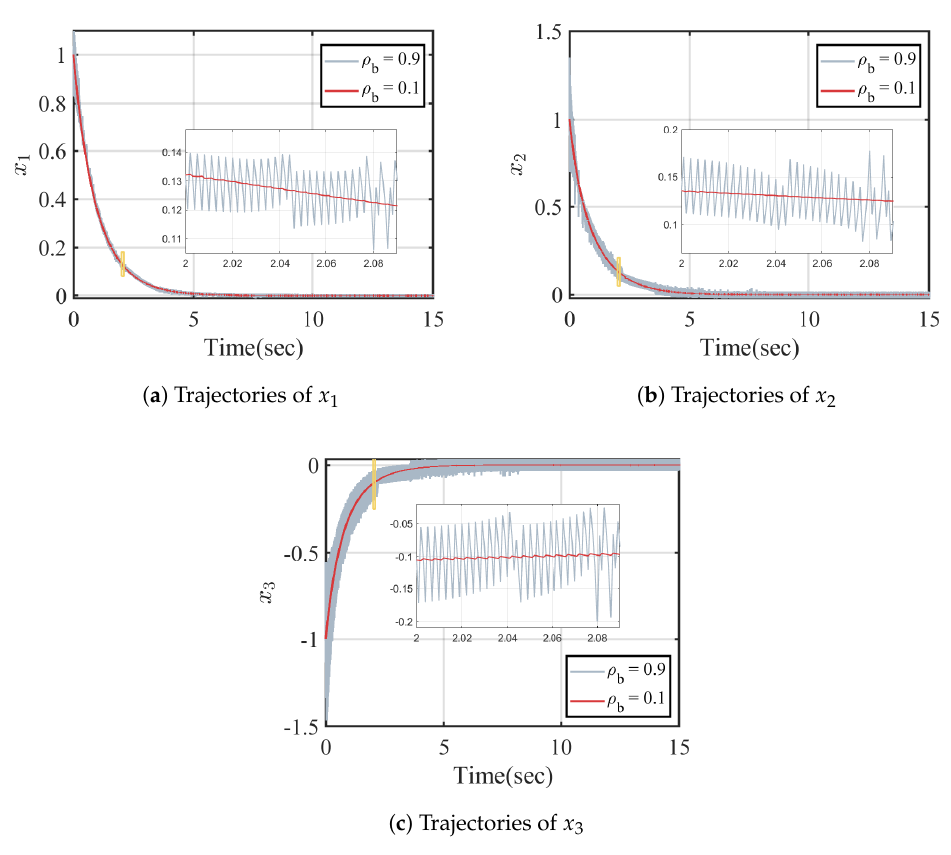
Figure 1. The state variable performance of the system controlled by cSMC in the case of ρ b = 0.9 (gray solid line) and ρ b = 0.1 (red solid